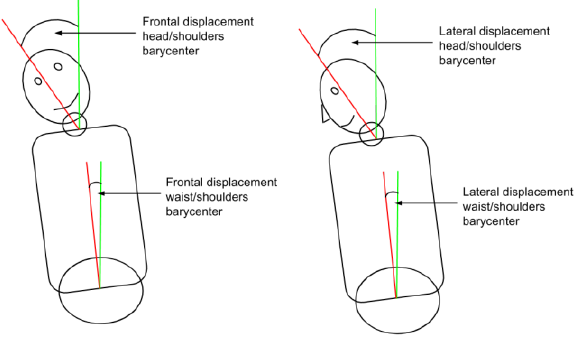
Figure 2. Displacements between head/shoulders and